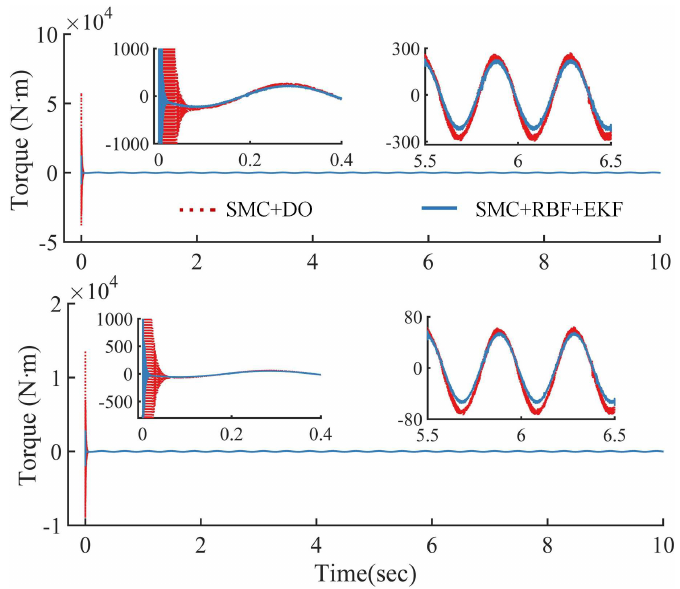
Figure 15. Torque control